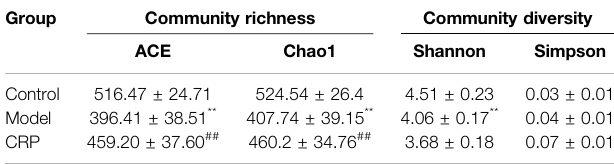
TABLE 1 | The diversity index of gut microbiota in rats in different groups.